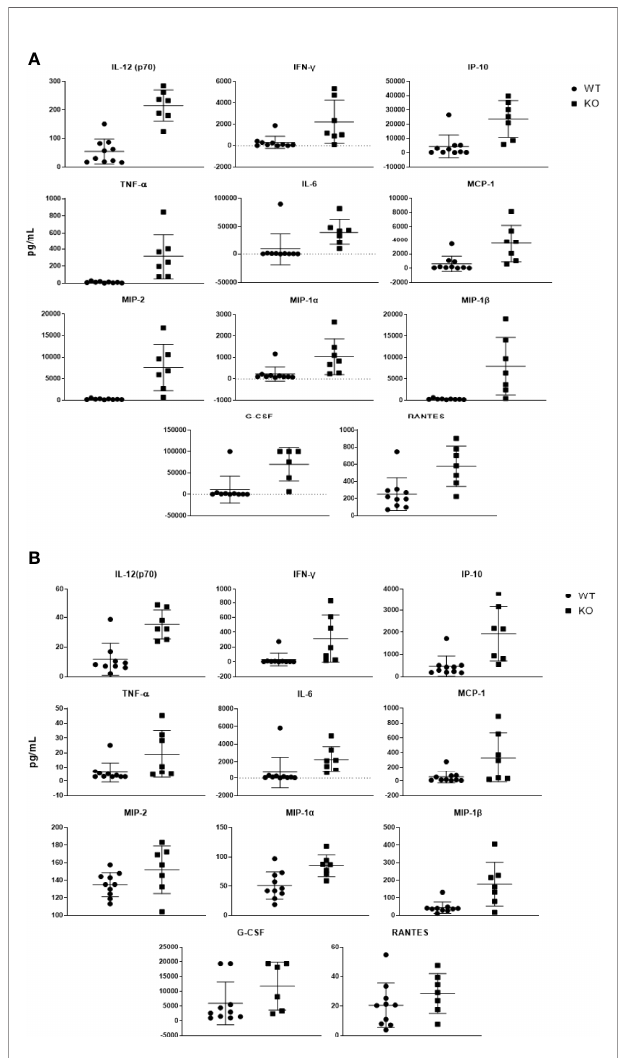
FIGURE 3 | Puma-dependent host responses during early pneumococcal pneumonia suppress production of cytokines in the lung. Cytokines expressed more than 3-fold in Puma -/- mouse lungs (A) and sera (B) are shown here. Cytokines were detected via magnetic bead panel using fl ow cytometry analysis. Values are reported as pg/mL. Mann-Whitney U tests were performed to determine signi fi cance, a =